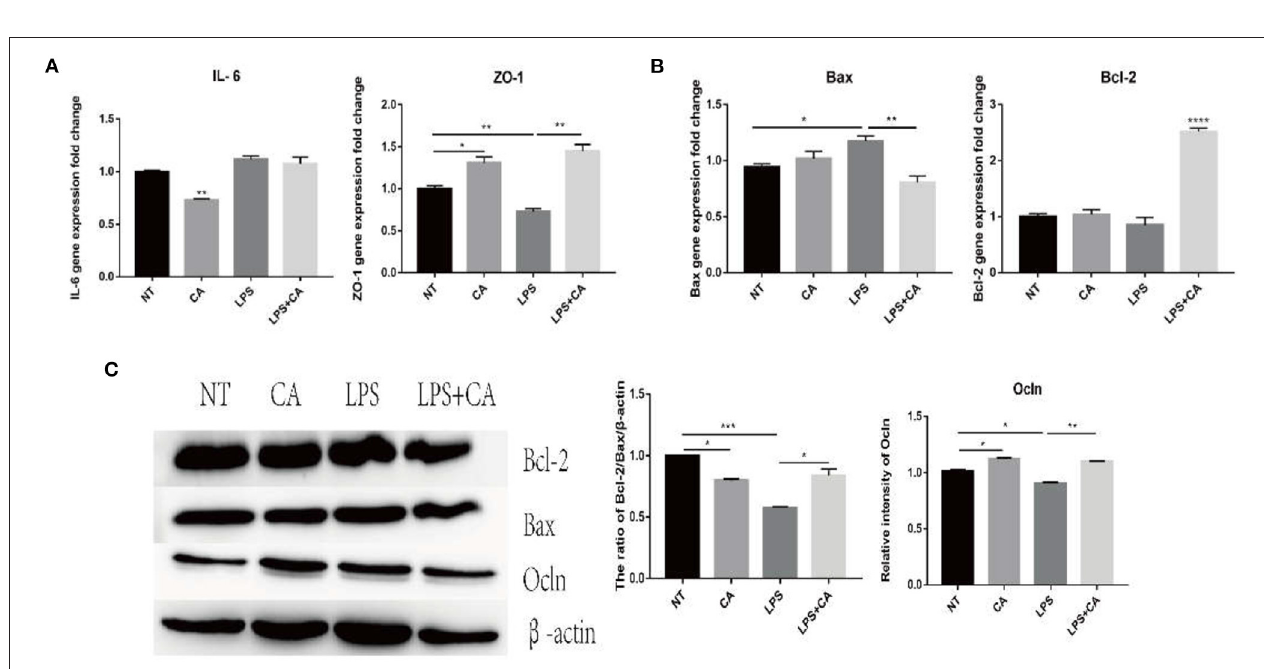
FIGURE 5 | Citric acid (CA) significantly attenuated the damage caused by LPS to IPI-2I cells. After the cells were treated with 4 mmol/L CA for 2h, LPS (1 µ g/mL) was added for 24h, and the samples were collected for total RNA and total protein extraction. (A,B) Expression of IL-6, ZO-1, Bax, and Bcl-2 was detected by RT-PCR. (C) Representative immunoblot of Ocln, Bax, and Bcl-2 expression in IPI-2I cells ( n = 3, means ± SEM, Student’s t -test, * P < 0.05, ** P < 0.01, *** P < 0.001, **** P <